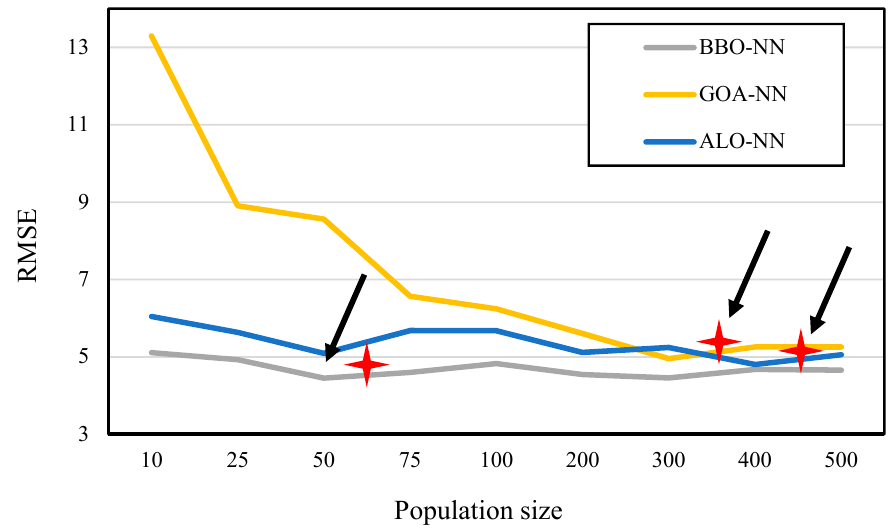
Figure 6. The final root mean square error (RMSE) values versus the population size.